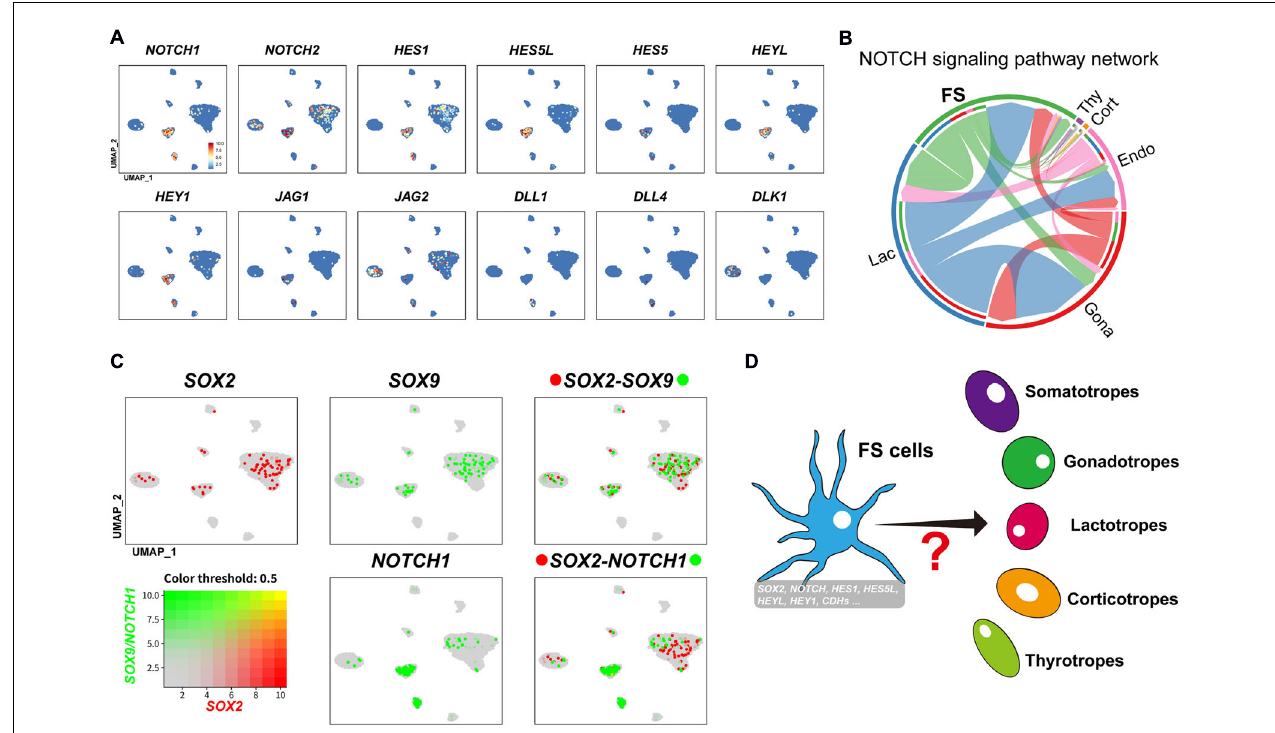
FIGURE 9 | (A) UMAP maps showing the abundant/specific expression of genes encoding Notch signaling components ( NOTCH1 , NOTCH2 , HES1 , HES5L , HES5 , HEYL , and HEY1 ) in FS-cell cluster and Notch ligands ( JAG1 , JAG2 , DLL1 , DLL4 , and DLK1 ) in FS-cells, endothelial cells, and endocrine cell clusters (Gona and Lac). Dark red and light blue indicate high and low expression levels, respectively. (B) The intercellular communication network of NOTCH signaling pathway. The circle segments represent the six main intercellular communication cell types with different colors. The edge width is proportional to the communication score between interacting cell clusters. (C) Co-expression analysis of SOX2 and SOX9 in chicken pituitary FS-cells and other cell clusters. Cells abundantly co-expressing SOX2 and SOX9 are shown in yellow. (D) A simplified model showing that a sub-population of FS-cell cluster co-expressing many progenitor/stem cell-associated factors previously reported (Notch signaling components, CDH1 and SOX2 etc. (Vankelecom, 2010; Edwards and Raetzman, 2018) may represent the progenitor/stem cell sub-population, which could differentiate into endocrine cells ( e.g. , lactotrophs and gonadotrophs) under some unknown induction signals in adult pituitary (marked by question